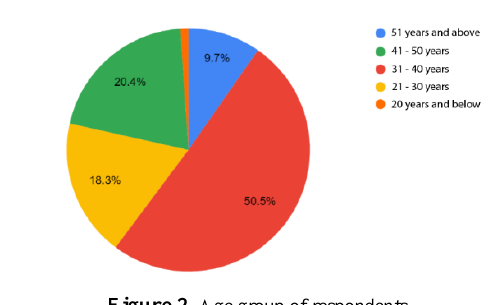
Figure 2. Age group of respondents.